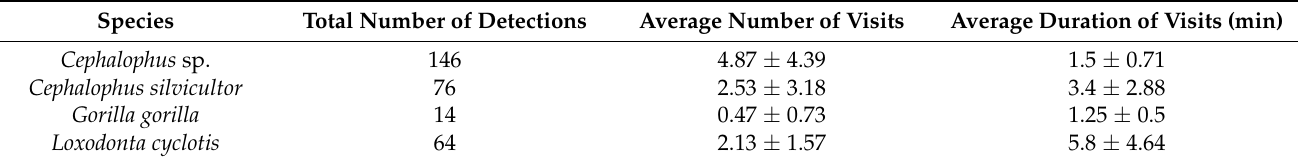
Table 1. List of detected species involved in seedling consumption with: the number of detections, number of visits (average ± SD) and duration of consumption on the visits (average ± SD) within the plantations.